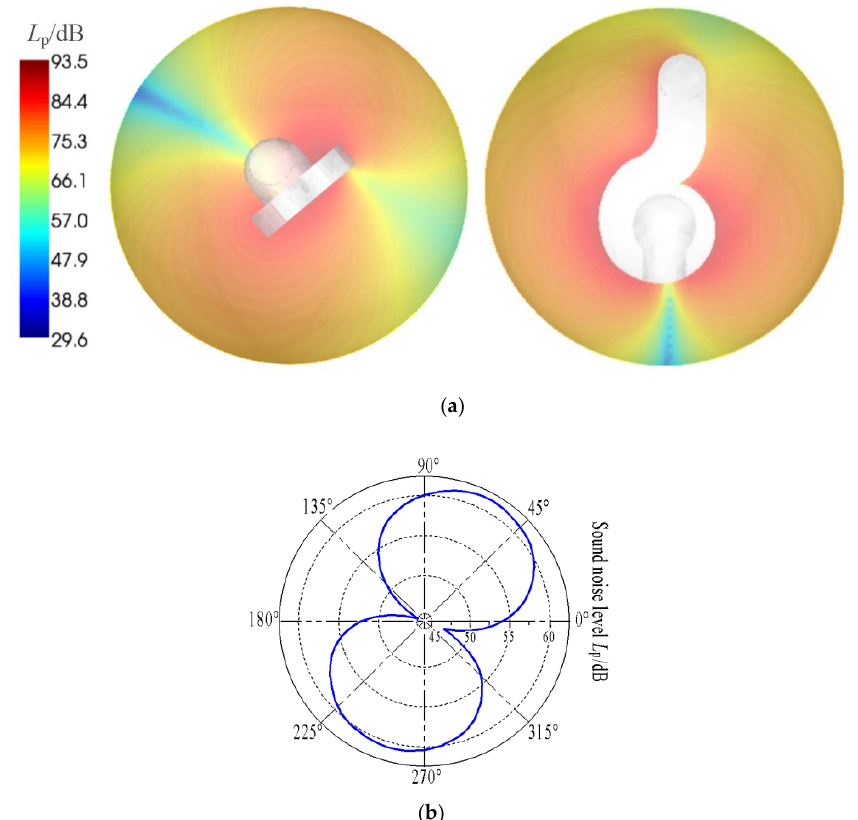
Figure 19. Radiated noise characteristics under 6 f 0 : ( a ) cloud map; ( b ) directivity and radiated noise level curve.